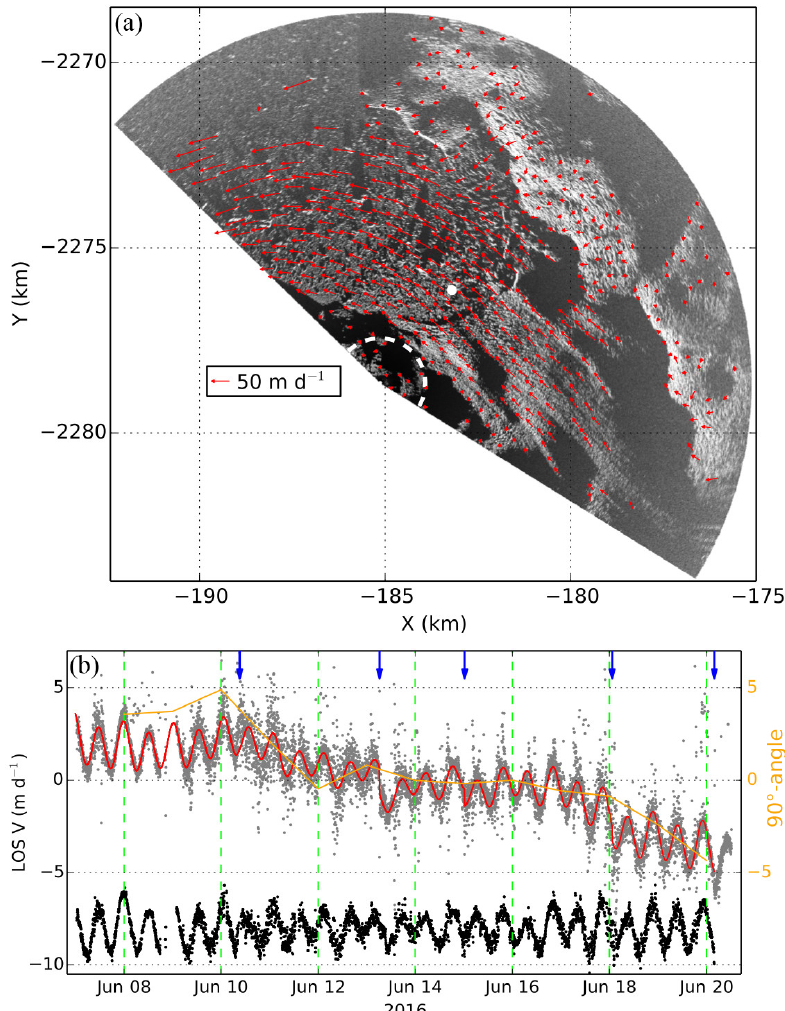
Figure 3. (a) Ice velocity estimated by feature tracking using a pair of TRI intensity images separated by 1 day in the 2016 campaign. Dashed white line outlines the area with (nearly) stationary points used to define uncertainty of velocity estimate; the rms of velocity estimates (without detrending) by feature tracking within the dashed outline is < 1md − 1 . (b) TRI-observed LOS velocity time series for a single point, marked by white dot in (a) . Grey dots show velocities derived from unwrapped phases, red curve shows the model used to remove perturbations caused by calving events, and black dots show detrended time series offset by − 8md − 1 . Blue arrows mark large calving or calving-like collapse events. Orange line shows changes of angle between LOS and 2-D ice velocity direction by feature tracking. The LOS velocity variation for a period longer than 1d is mostly due to changes in background velocity